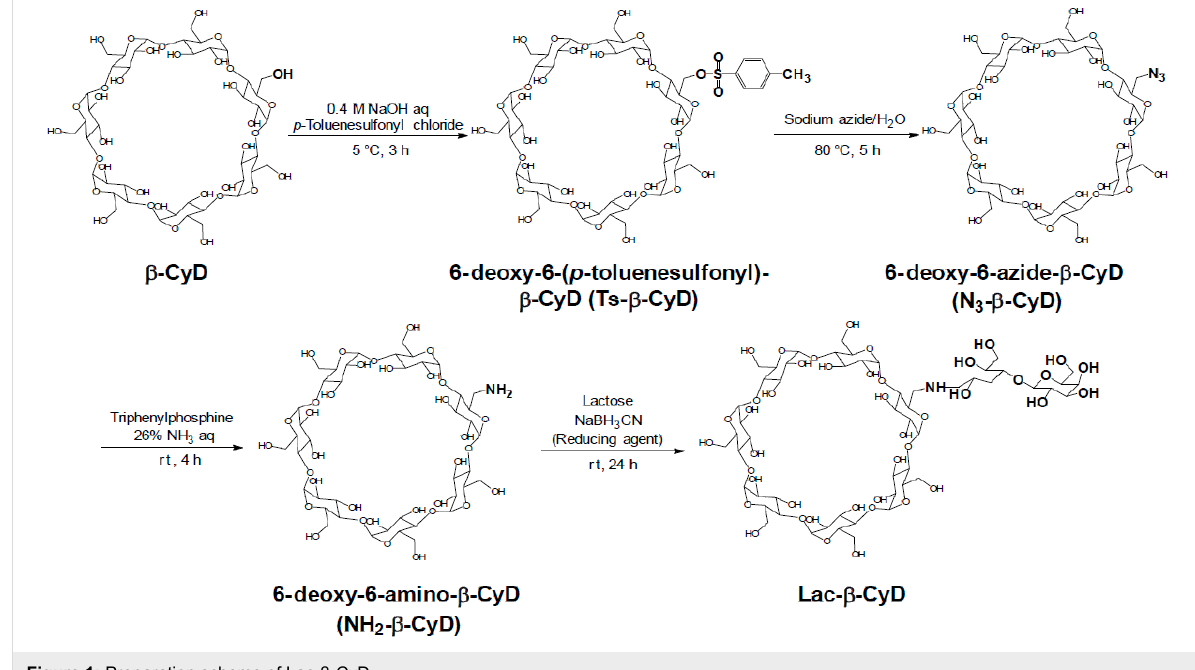
Figure 1: Preparation scheme of Lac- β